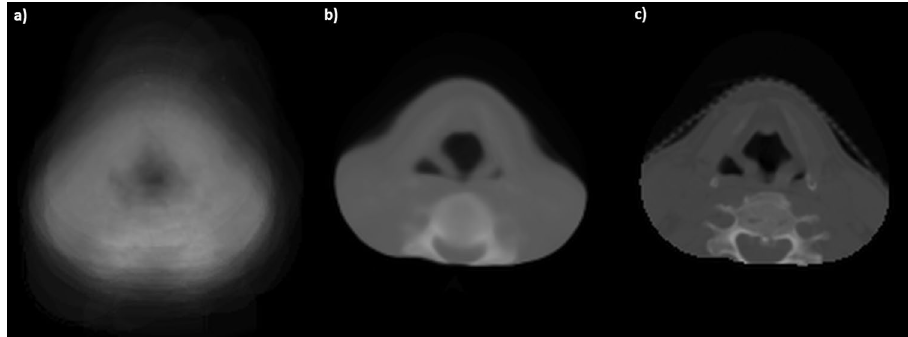
Figure 2. Elastic image registration (EIR) results. Average of the patient population computed tomographic scans ( a ) before EIR and ( b ) after EIR, compared to ( c ) the corresponding reference patient’s scan.